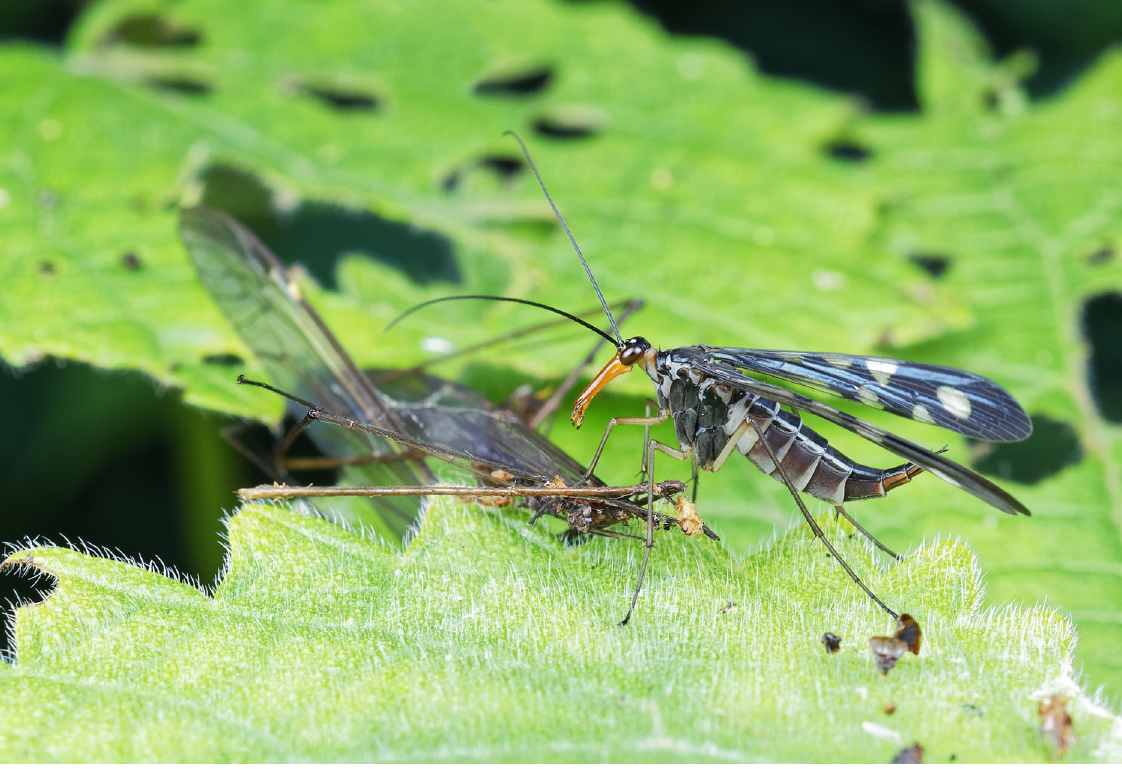
Fig. 4. Neopanorpa ocellaris (Navás, 1908), living female. The female is feeding on a dead crane fly. Photo by Wei-Liang Xie from Huanjiang County, Guangxi Province,